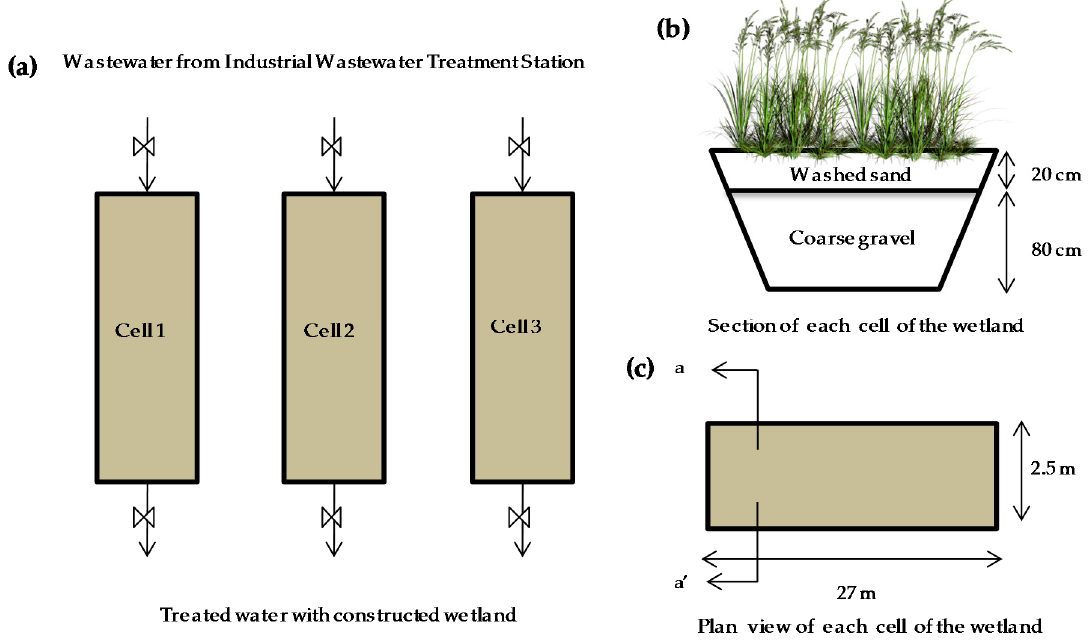
Figure 1. Study location and treatment system of constructed wetland: ( a ) three cells working in parallel; ( b ) sectional view of each cell of the wetland and composition; ( c ) plan view of each cell of the wetland.